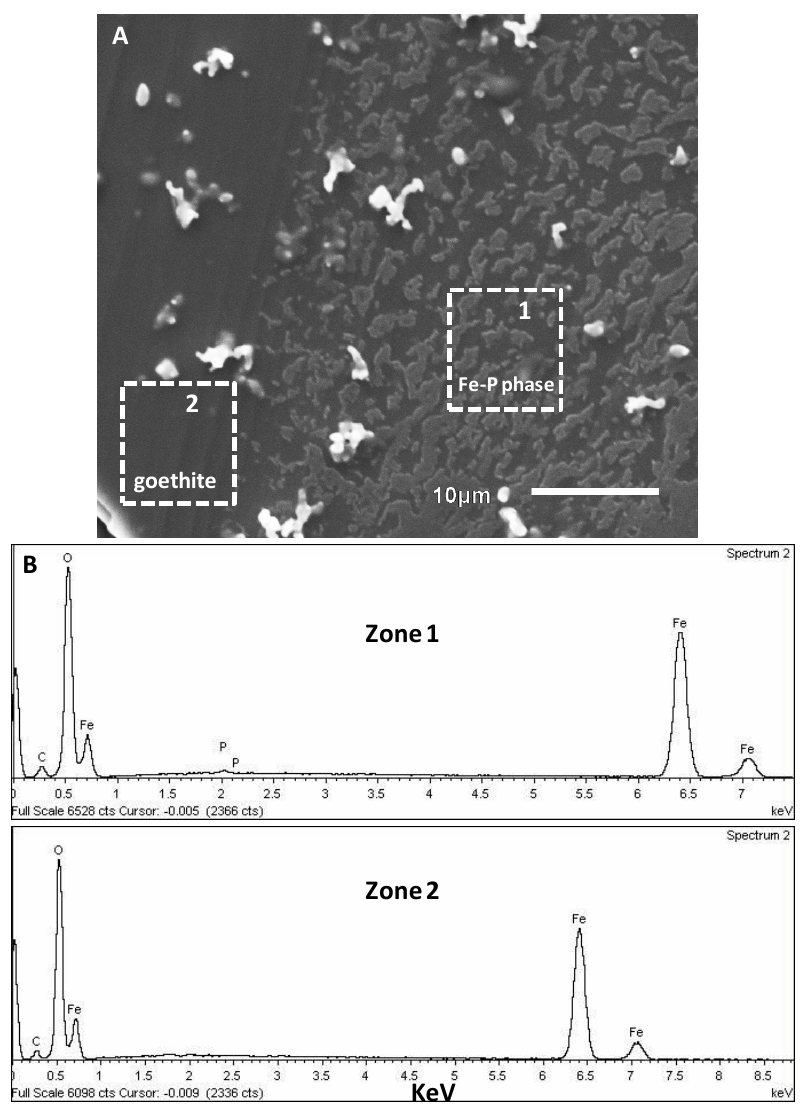
Figure 9. ( A ) SEM image showing the ex situ formation of Fe-P precipitates on goethite after 3 days of interfacial reaction in a 50 mM NH 4 H 2 PO 4 (pH 4.5) solution. The goethite substrate was covered with a thin layer of precipitates. The dotted rectangles in ( A ) indicate areas chosen for EDX analyses. ( B ) EDX spectra taken from zone 1 and 2 shown by dotted rectangles in ( A ), indicating an iron phosphate phase and a goethite substrate, respectively.